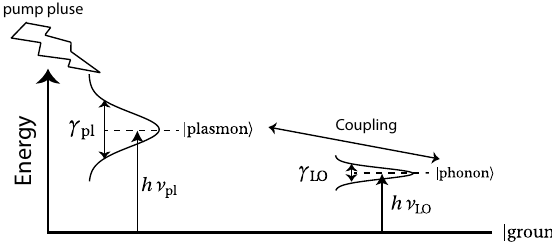
Figure 1. Energy diagrams of interactions between discrete levels with